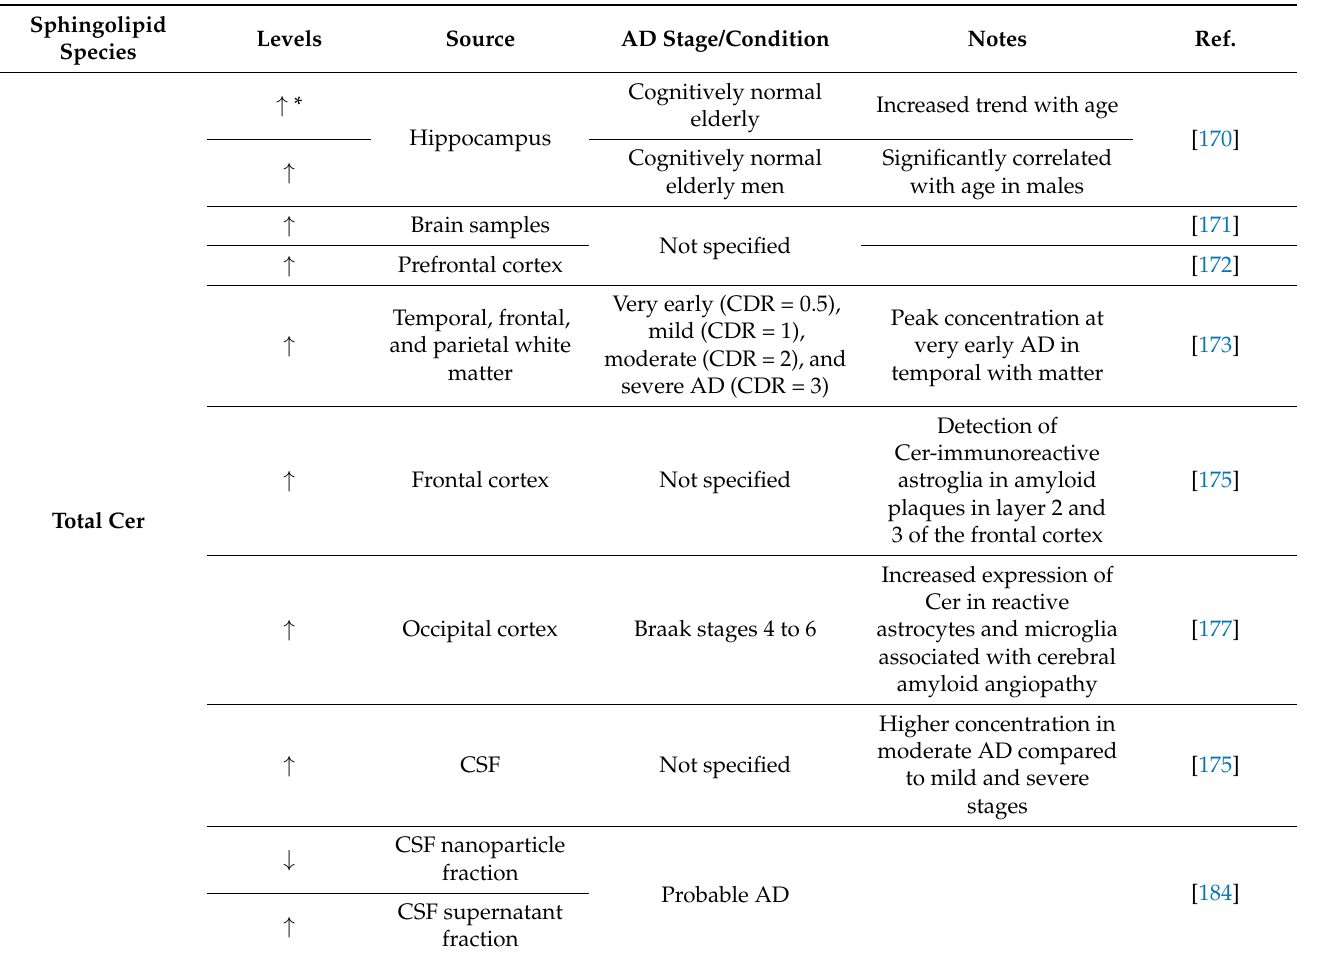
Table 2. Summary table of human sphingolipidomics. The upward arrows refer to an increase in levels compared to the controls, while the downward arrows refer to a reduction. The asterisk indicates non statistically significant data. Ceramide (Cer), hexosyl-ceramide (HexCer), galactosyl-ceramide (GalCer), glucosyl-ceramide (GlcCer), lactosyl-ceramide (LacCer), sphingomyelin (SM), dihydro- sphingomyelin (dhSM), dihydro-ceramide (dhCer), sphingosine (Sph), sphingosine